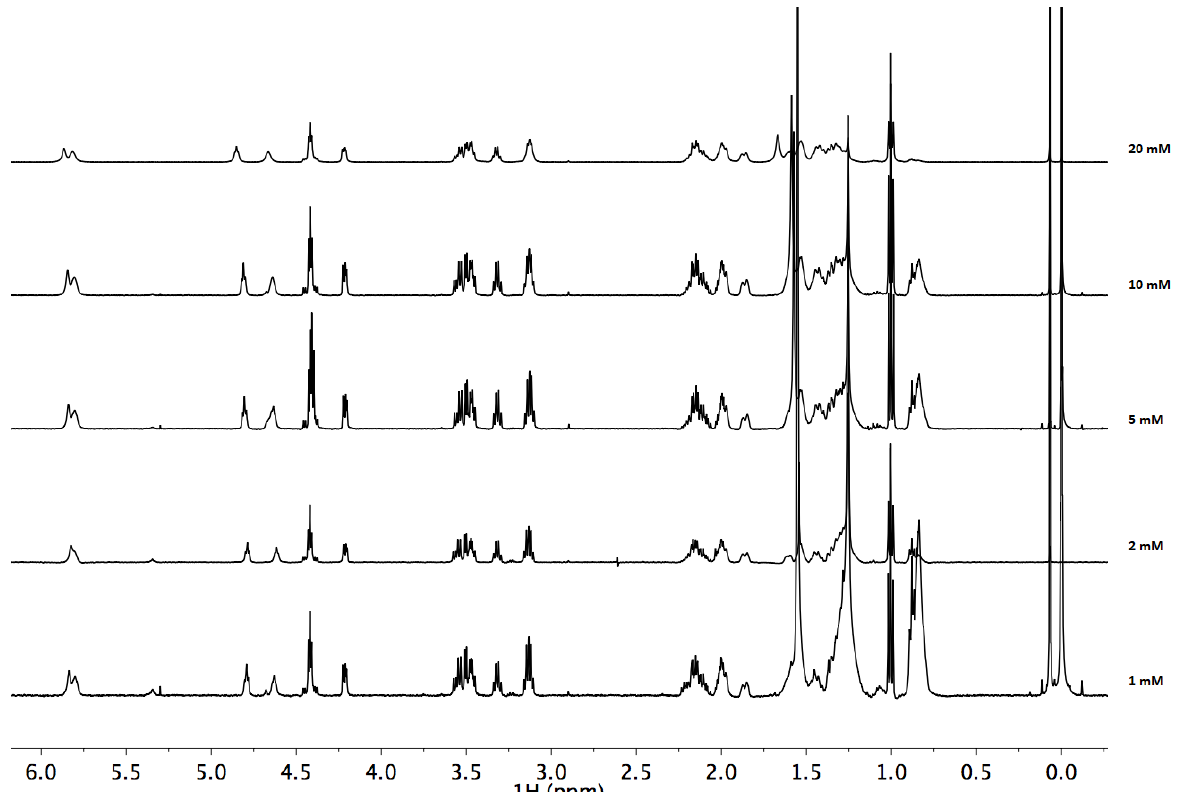
Figure 5. 1 H NMR of compound 3 in CDCl 3 at +25 °C and at different concentrations (1, 2, 5, 10 and 20 mM).